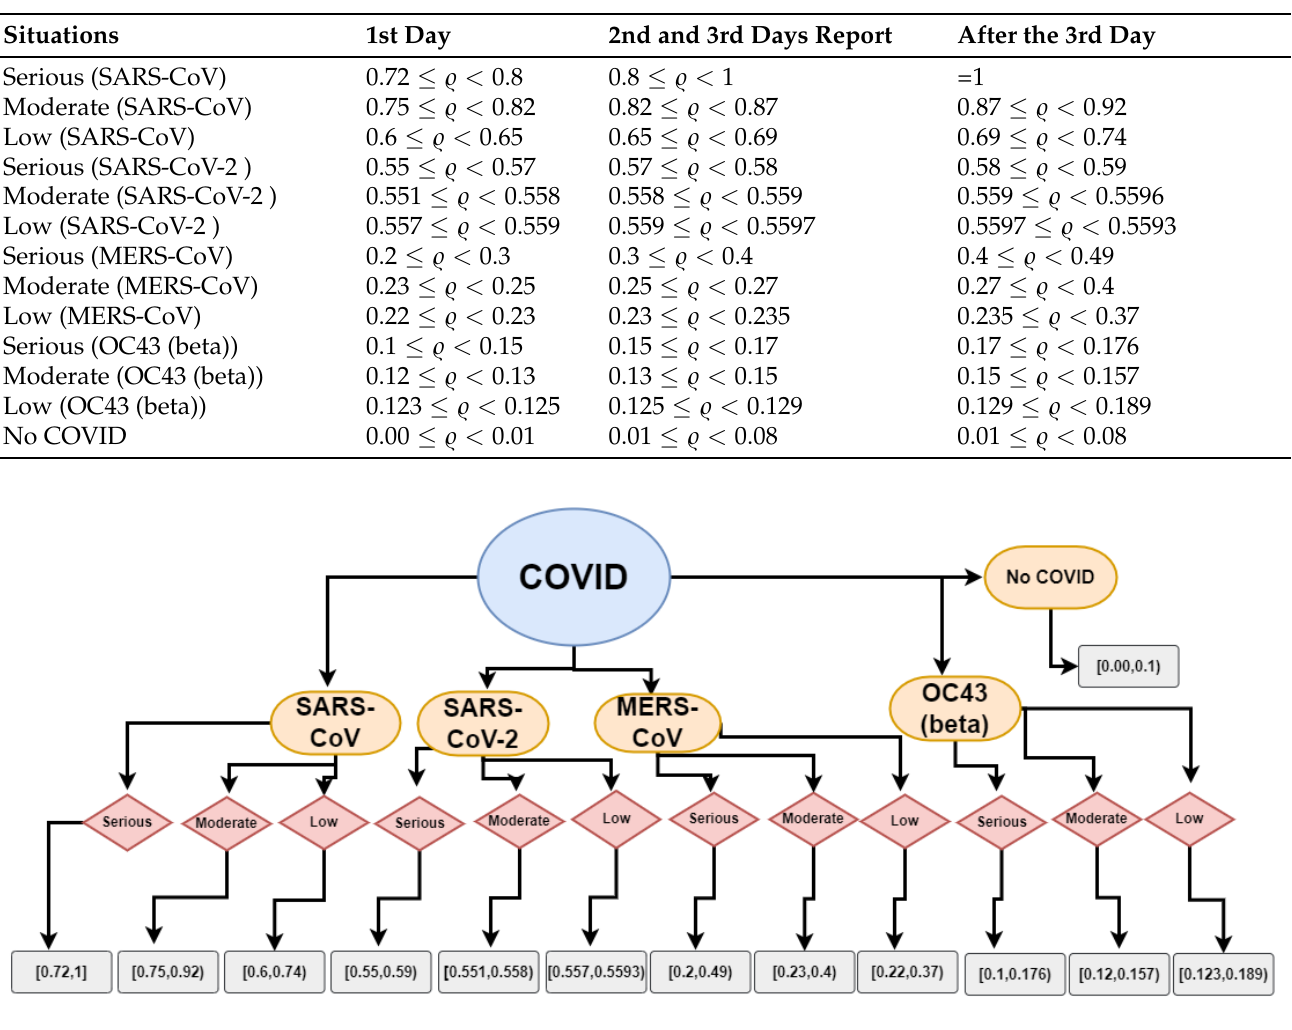
Figure 2. Flowchart of various ranges related to COVID-19’s mentioned